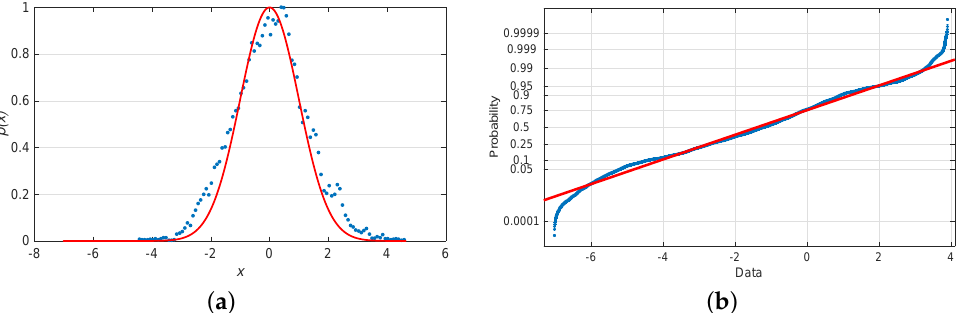
Figure 4. ( a ) (Doted line) The probability density resulting from the variable x generated by the electronic circuit is represented by the normalized histogram, compared with the approximation resulting from the evaluation of the time series by the Gaussian function (solid line). ( b ) Normal plot of the analyzed time series (blue line) against the estimated approximation (red line).